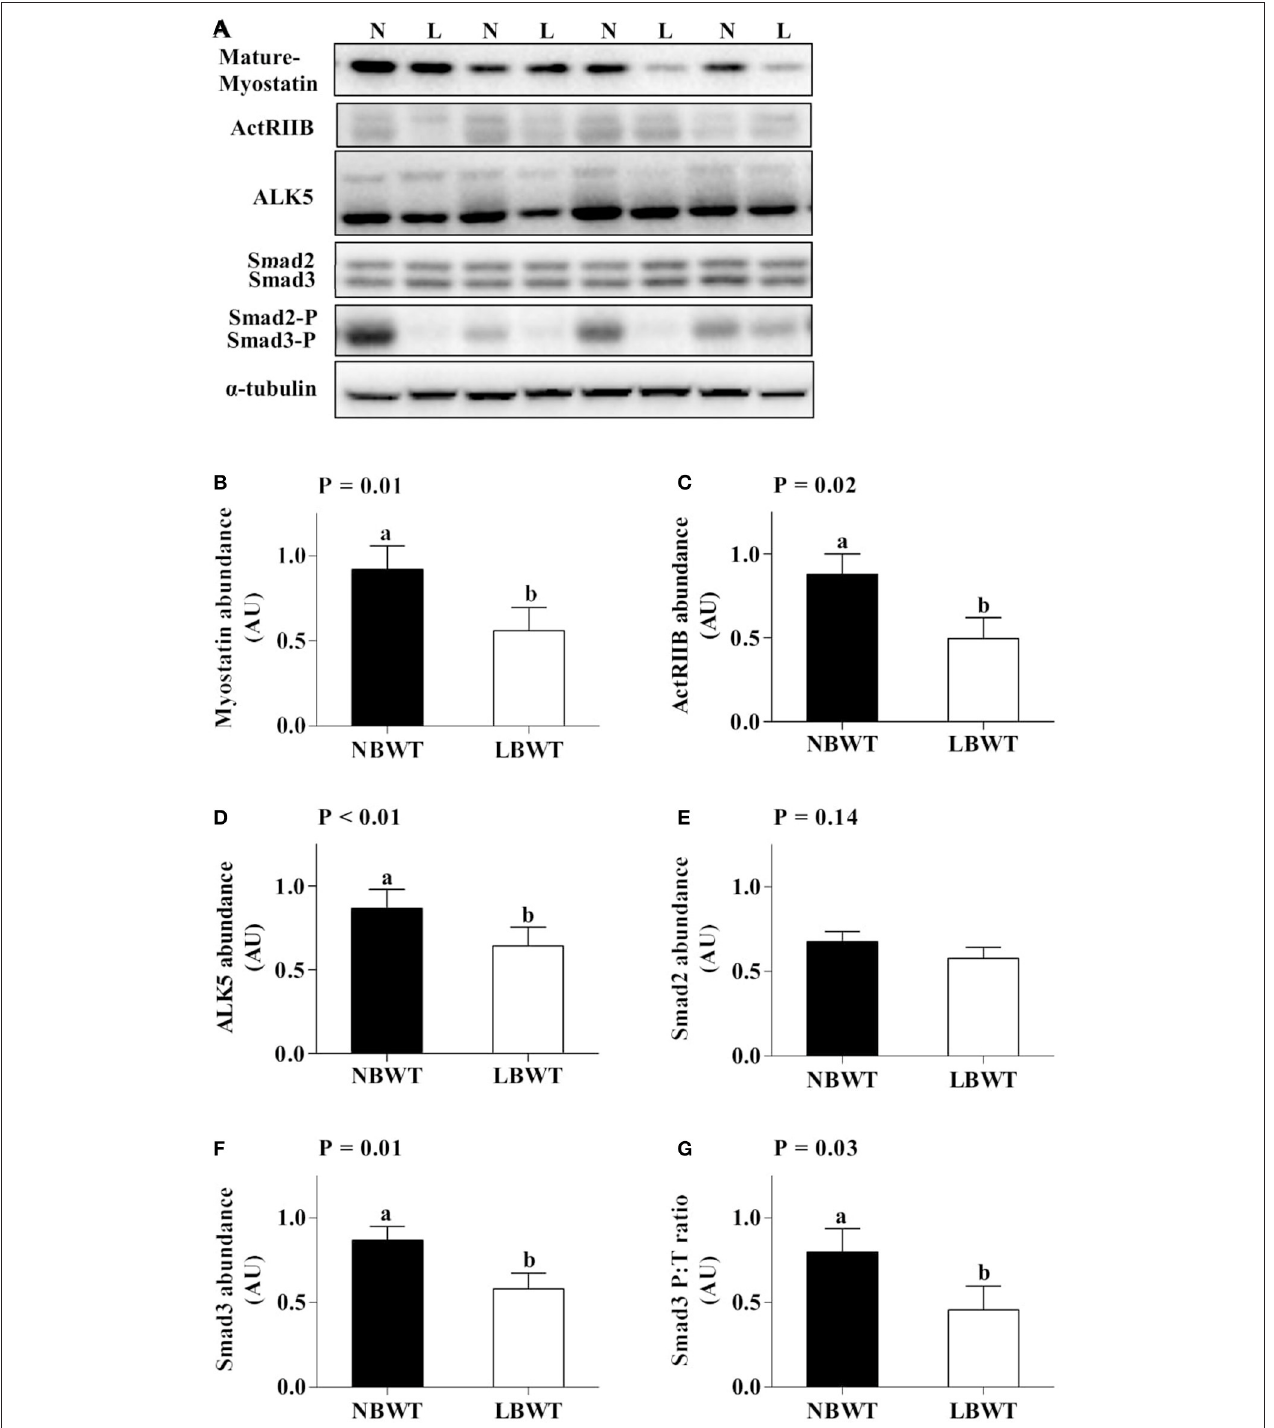
FIGURE 10 | Myostatin signaling in longissimus dorsi muscle of low-birth-weight (LBWT) and normal-birth-weight (NBWT) neonatal pigs. (A) : Representative western blots from four pairs of LBWT and NBWT pigs (N, NBWT; L, LBWT). (B – G) : Protein abundance of myostain, ALK5 and ActRIIB, and protein abundance phosphorylation of smad2/3. Abundance was normalized to α -tubulin and phosphorylation normalized to the corresponding non-phospho-proteins. Results are means ± SE. n = 12. Values with different letters differ significantly ( P ≤ 0.05).